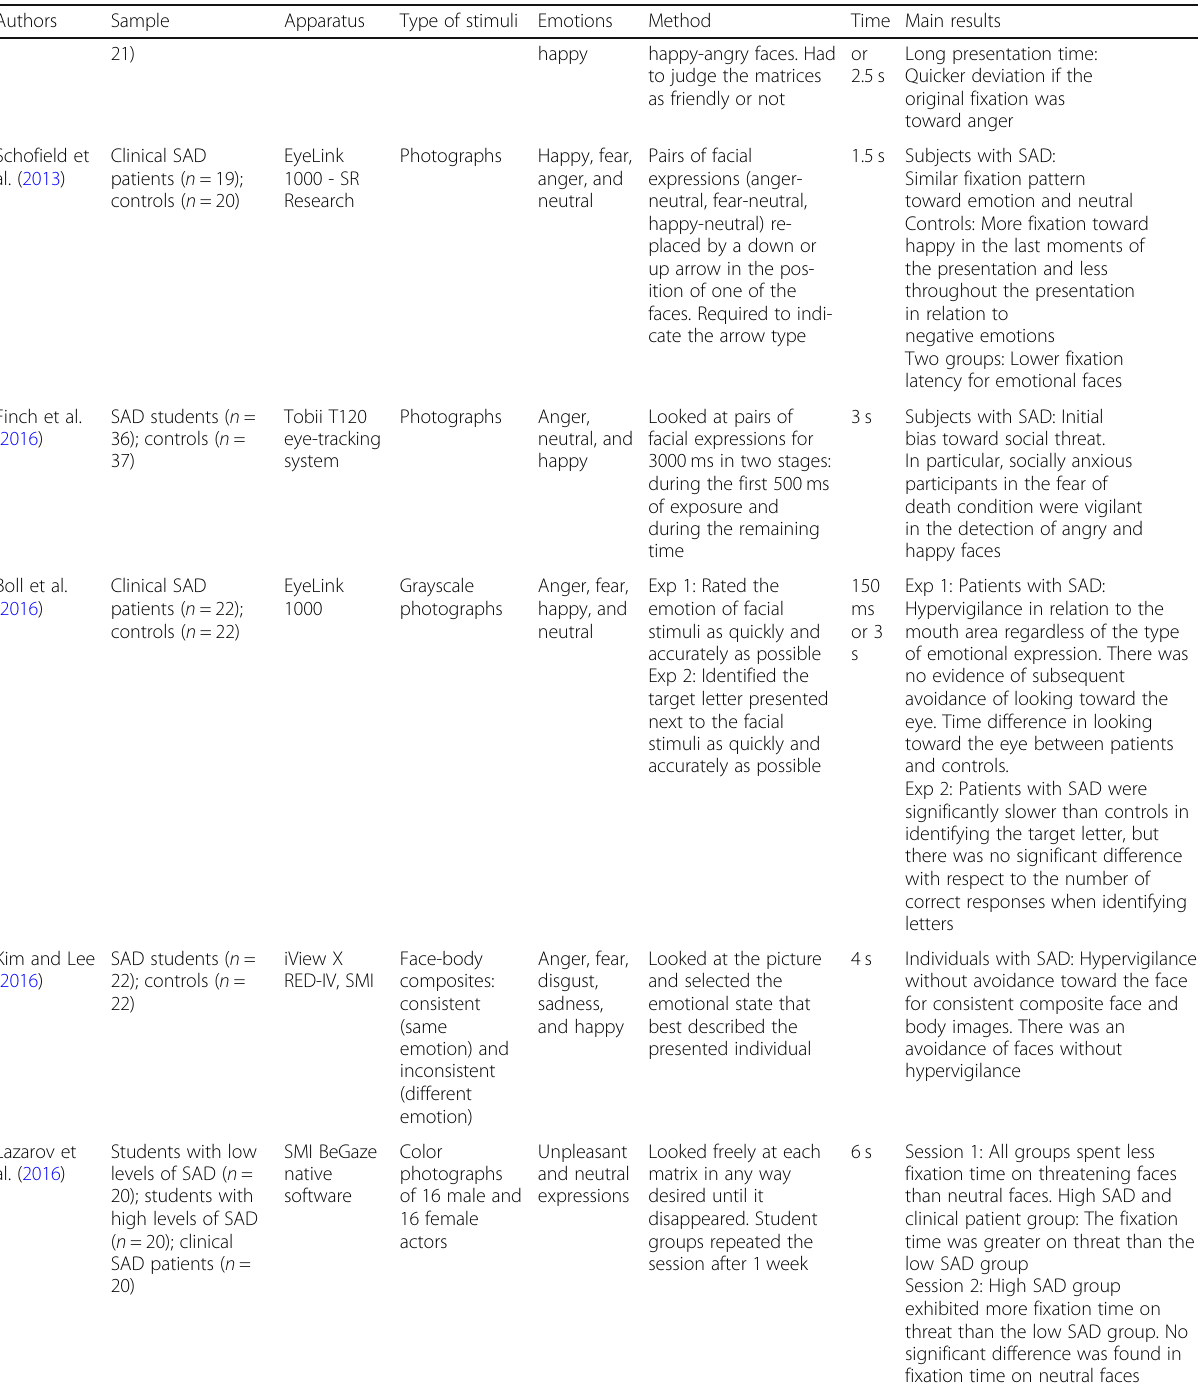
Table 2 Studies selected for the review according to author, sample description, type of stimuli, and emotions